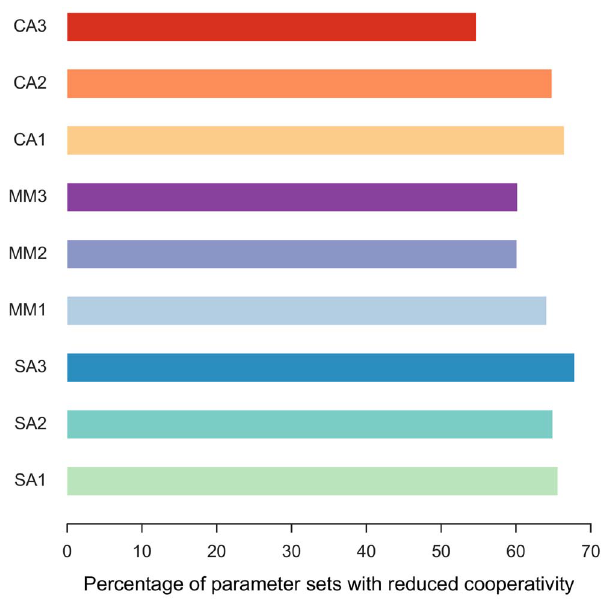
Figure 5. Cumulative effect of two positive feedback loops on the core motif. The percentage of random parameter choices for which the cooperativity was improved by adding a second positive feedback to the nine positive feedback motifs in Figure 1. The original positive feedback motifs (shown on the y-axis) were modified by adding a second positive feedback different from the first, i.e., each of the other eight.